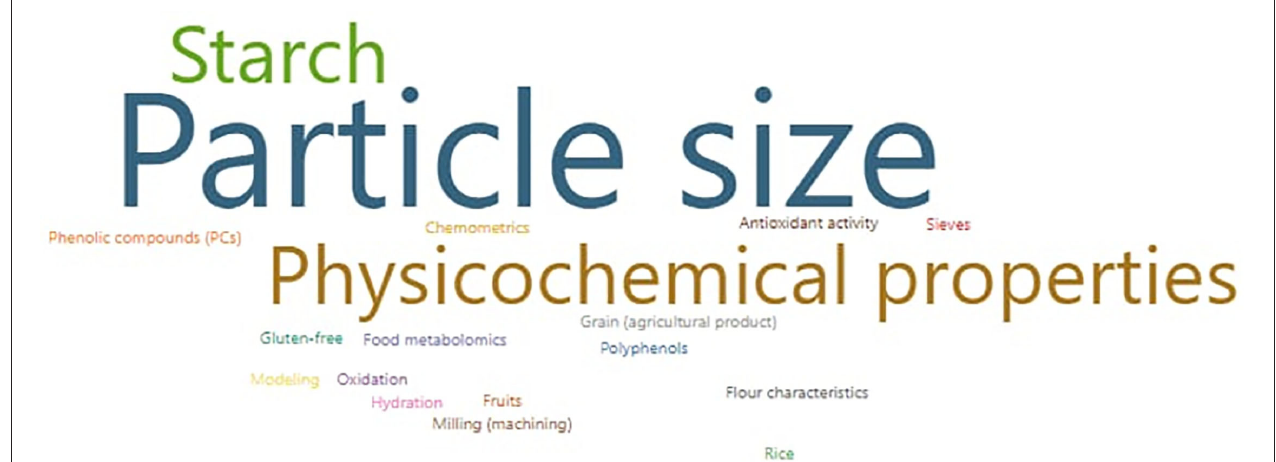
FIGURE 8 | Keywords. Source: Vantage point software (through information provided by the